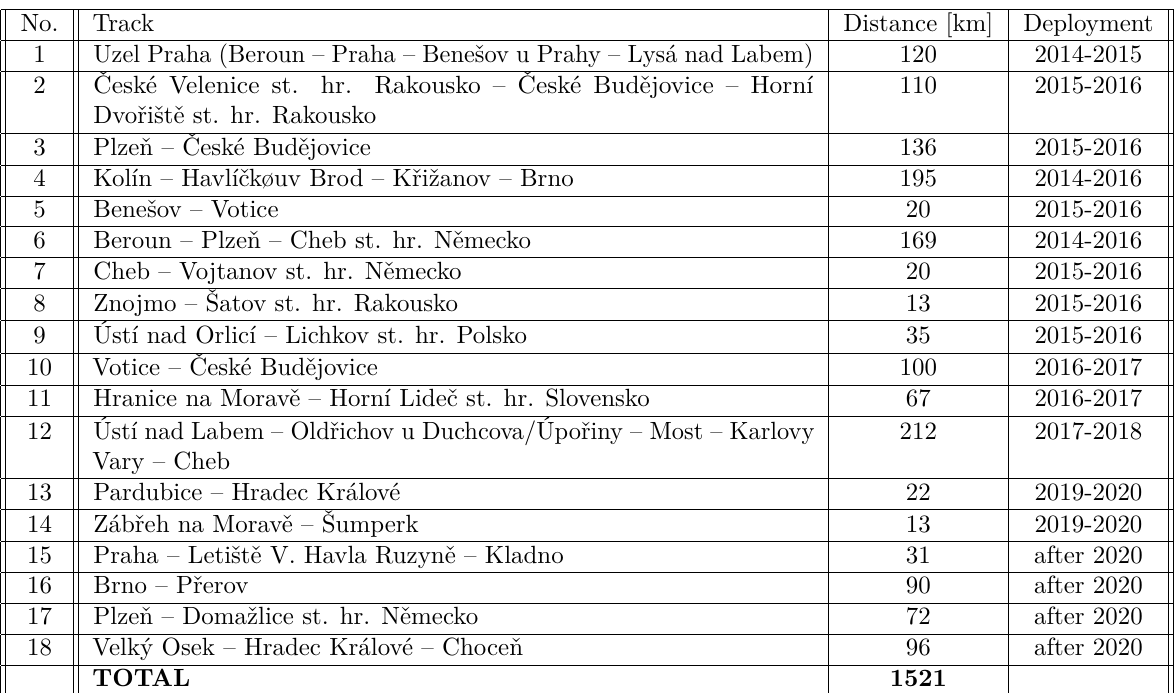
Table 1. Expected track deployment with GMS-R [3]